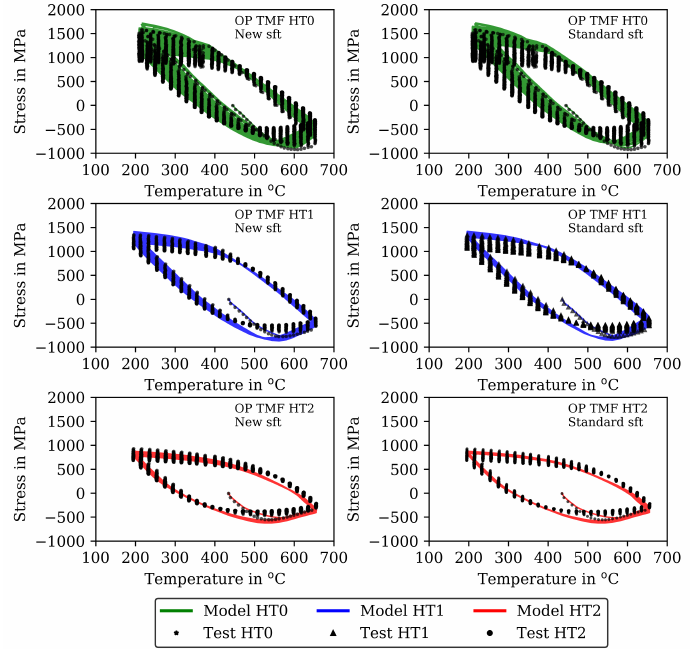
Figure 10. Stress–temperature diagrams for the measured stress and stress calculated with the viscoplasticity model for the out-of-phase TMF tests for the HT0, HT1, and HT2 material (mechanical strain amplitude of 0.01). New isotropic softening ( left ) and standard isotropic softening ( right ). Incomplete data for HT1 due to interrupted data